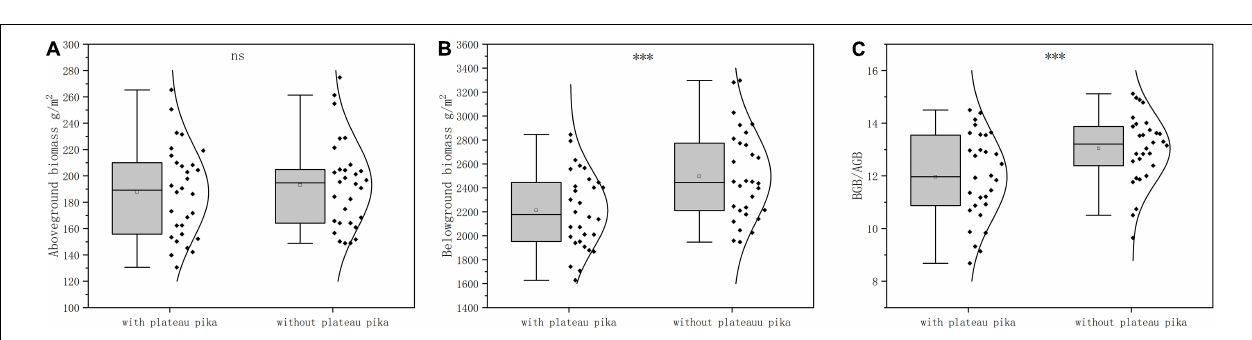
FIGURE 1 | Graphical representation of the hypothesis-based structural equation model of site and soil properties on BGB/AGB. Significant variables were included to predict BGB/AGB. AGB, aboveground biomass; BGB, belowground biomass.